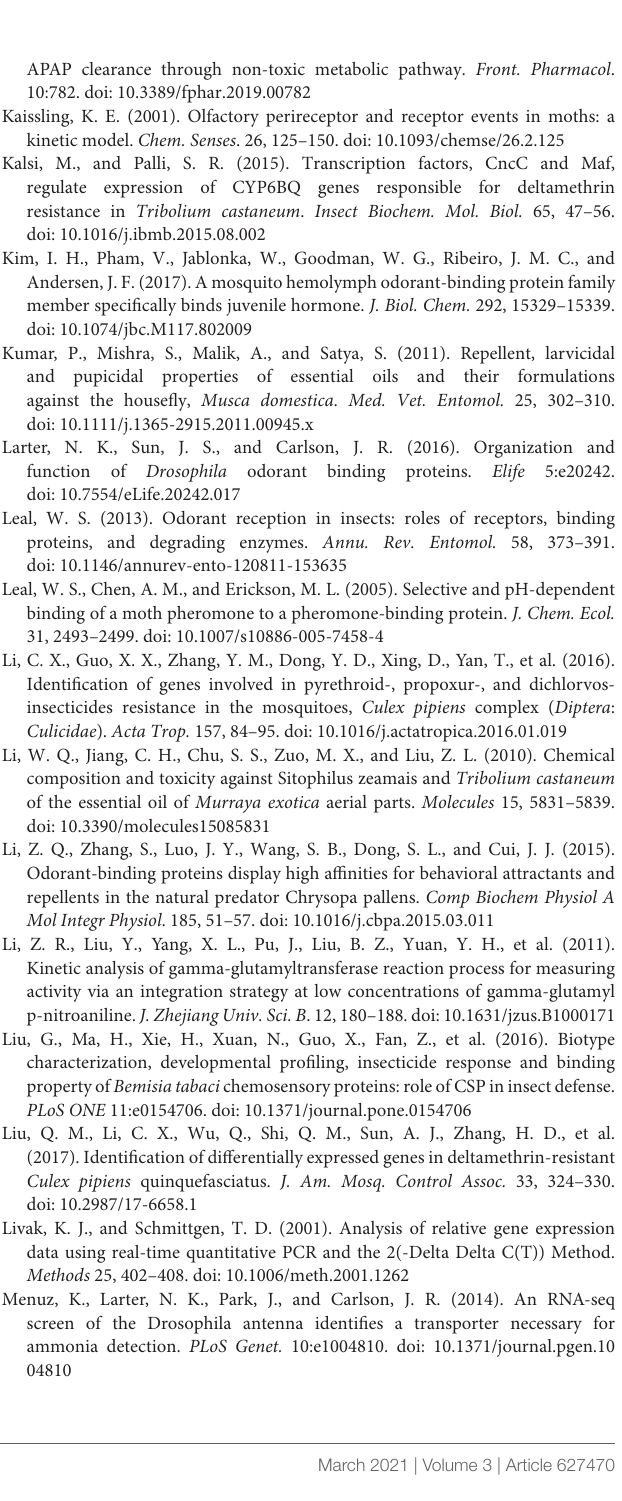
Supplementary Figure 1 | ORF and amino acid sequences of the TcOBPC17 gene. The ORF sequence of the TcOBPC17 gene was identified with DNAMAN. The corresponding amino acids are shown below the ORF sequence.